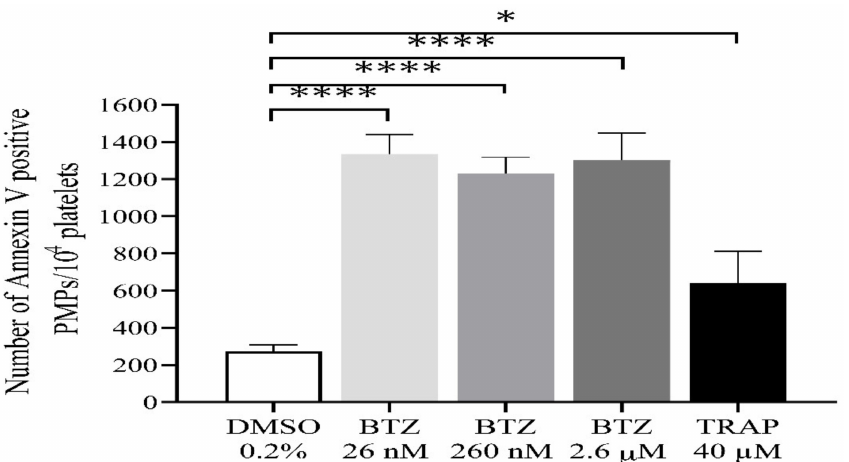
Figure 5. Detection of PMPs in BTZ-pretreated human GFPs. GFPs were treated with BTZ, TRAP (positive control) and DMSO (negative control) for 60 min. PMPs were analyzed by flow cytometry. The PMP gate was set using size (0.3–1 µ m) calibration beads (Megamix-Plus FSC). Mean ± SEM of 5 experiments for TRAP or 10 experiments for DMSO and BTZ is presented. The level of significance was determined using ANOVA and Dunnett’s multiple comparisons test; * p < 0.05 and **** p < 0.0001 compared to the DMSO group. BTZ: bortezomib; DMSO: dimethyl sulfoxide; PMPs: platelet-derived microparticles; TRAP: thrombin receptor-activating